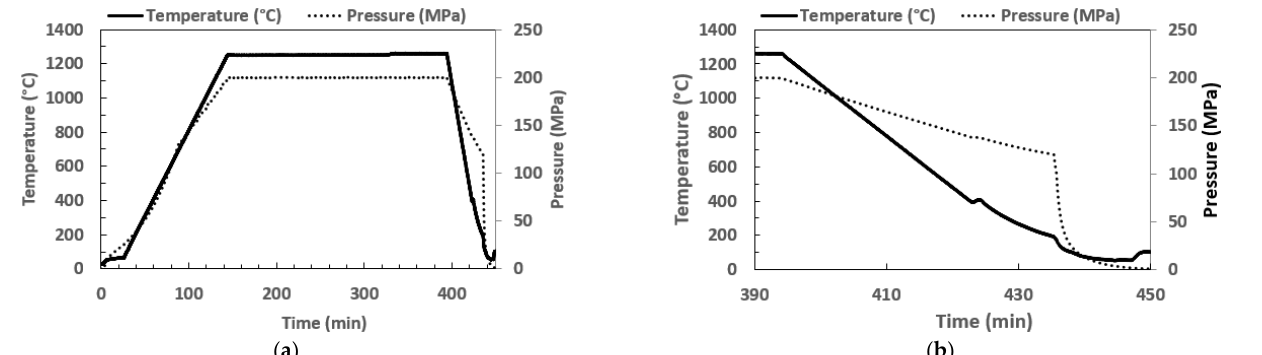
Figure 5. T-t-P profile; ( a ) General, and ( b )